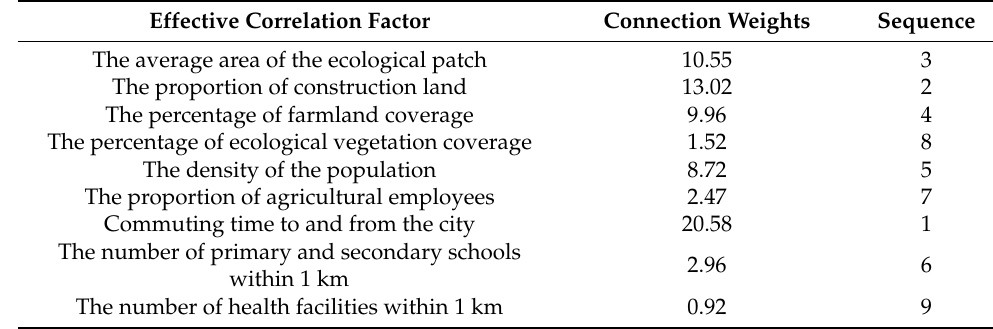
Table 6. Correlation weight statistics of each influential factor correlated with road density based on the random forest model.